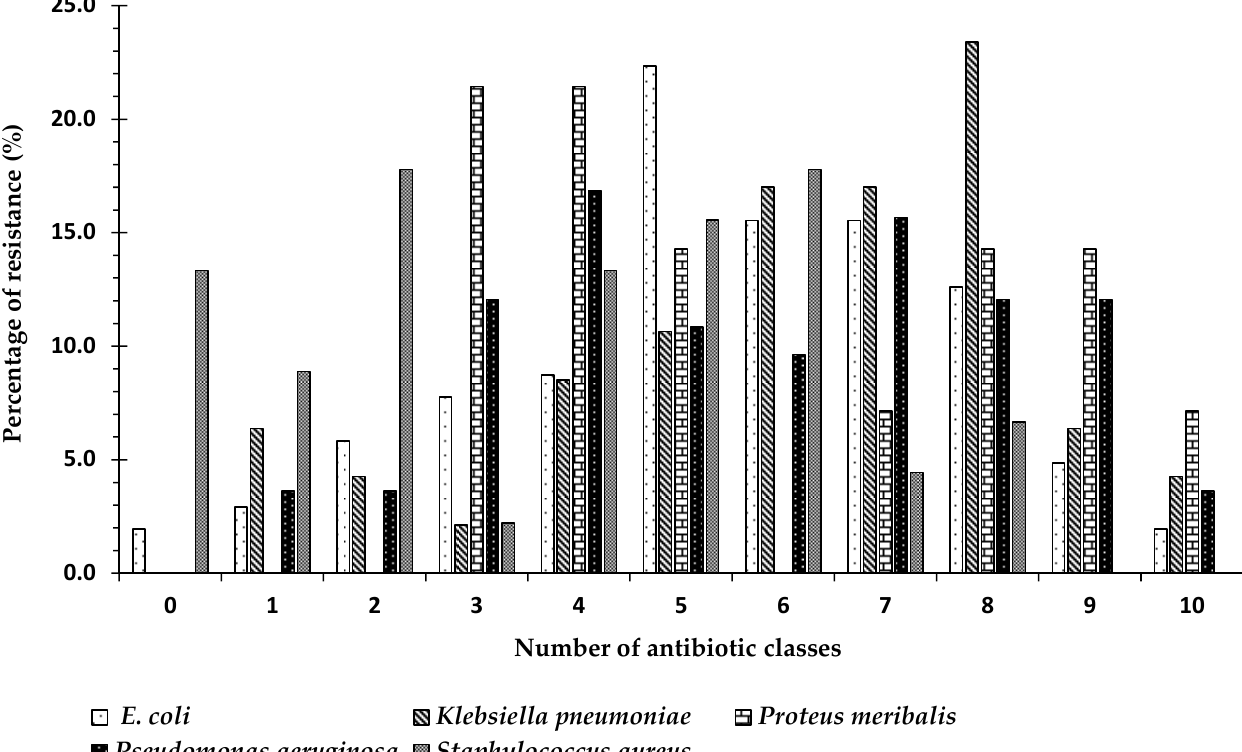
Figure 4. The percentage specific bacterial species that were resistant to antimicrobial agents from 11 antibiotic classes among isolated strains of the same species (obtained from 3 different countries: Egypt, Sudan, and Saudi Arabia): 0 means the percentage of strains that were not resistant to any antibiotic group (sensitive to all groups); numbers 1–10 indicate the numbers of classes to which the bacterial strain showed resistance; 1 indicates the percentage of strains that showed resistance to only one class of antibiotic; 2 indicates the percentage of strains that showed resistance to two classes of antibiotics amongst the 11 well known antibiotic classes, etc. Table 2. Summary of the patterns of resistance to antibiotic classes for Escherichia coli , Pseudomonas aeruginosa, and Klebsiella pneumoniae strains obtained from three different countries.